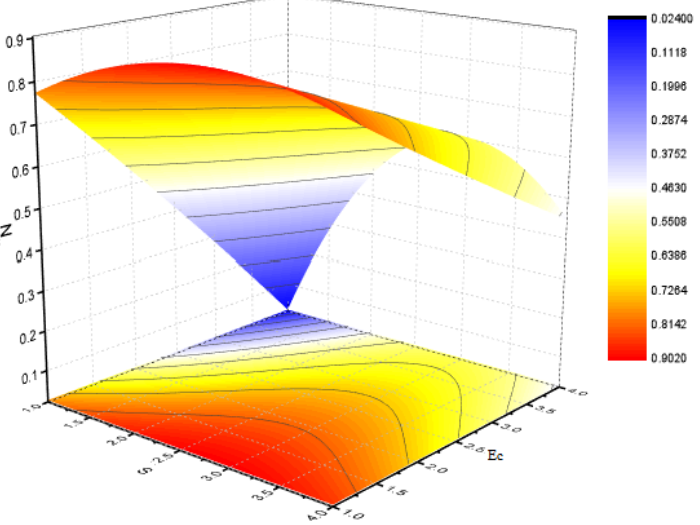
Figure 10. Effect of Nusslet number for S and Ec and fixed values of Re m = 2.5, Pr = 6.2, δ = 0.4, Φ 1 = 0.02, m =